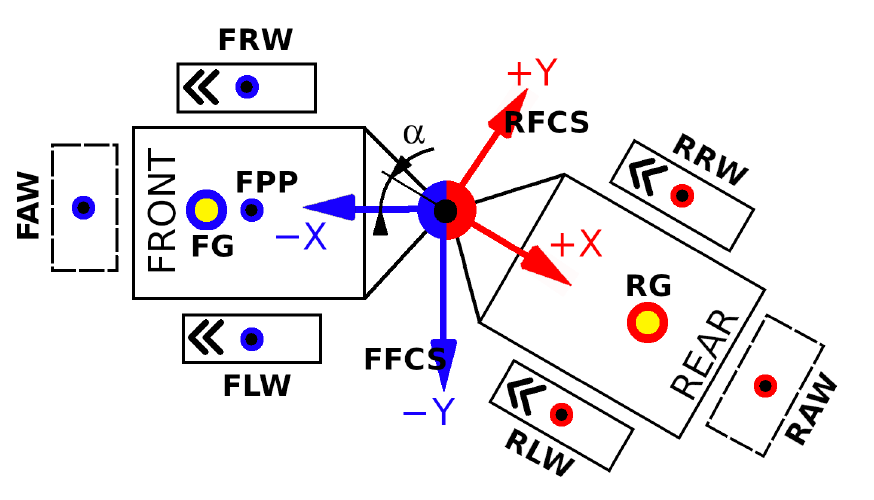
Figure 2. Important points of the skidder: FRW, FLW, RLW, RRW—coordinates of contact points of tires with slope/terrain, FG, RG—coordinates of centers of gravities for front and rear frames of skidder, FAW, RAW—coordinates of front and rear mount points for additional weights/loads, FFCS—front frame coordinate system (with Z-axis toward up), RFCS—rear frame coordinate system (with Z-axis toward up), FPP—coordinates of the front axle pivot